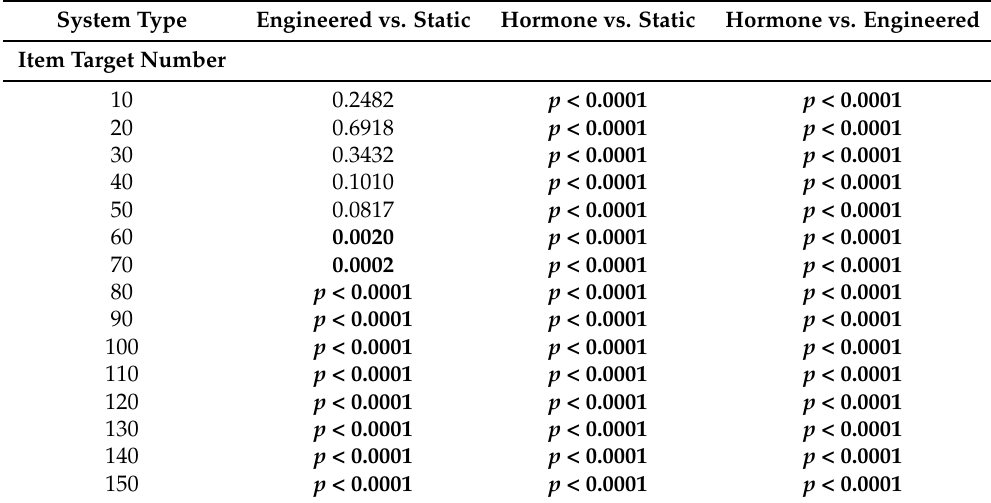
Table 3. Environment 2: Wilcoxon rank sum tests comparing the three systems for the tested item collection targets between 10–150 in terms of energy efficiency. Significant differences (indicated by a p value of <0.05) are highlighted in bold